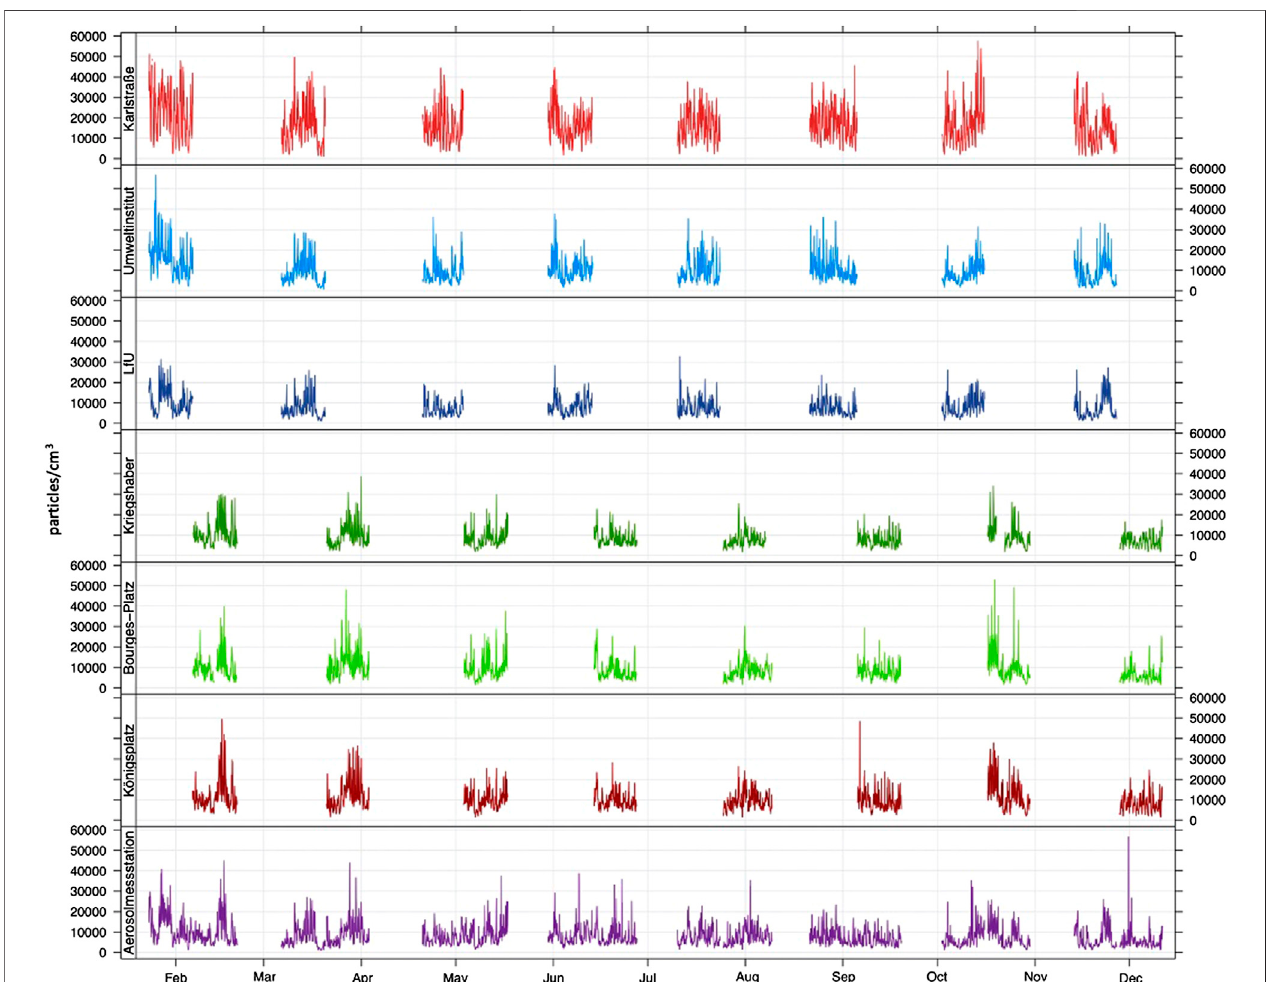
FIGURE 2 | Time series of the hourly UFP number concentrations in particles/cm 3 from the eight fi eld measurement phases of the measurement campaign 2017.